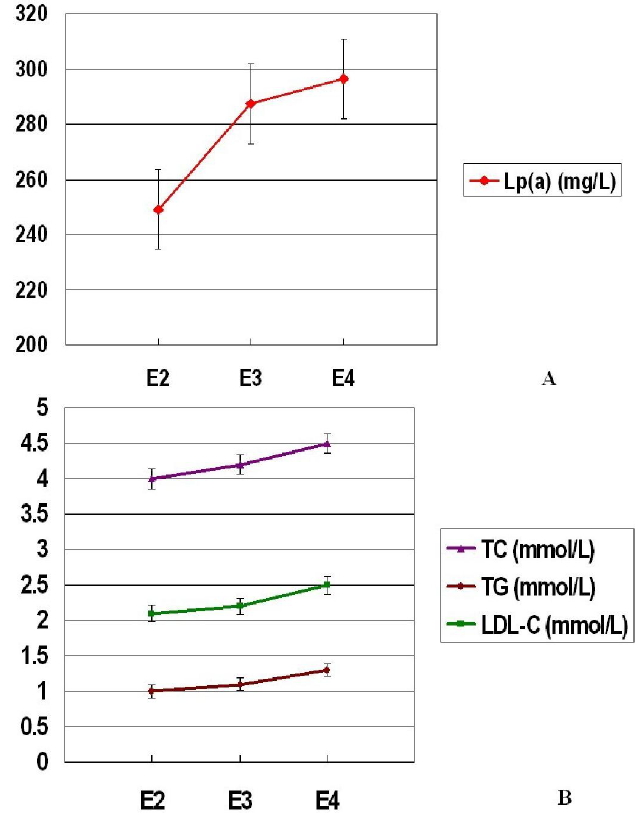
Figure 1. The influence of APOE alleles on serum lipid concentrations in the Guangxi Zhuang children. Though no significant differences in serum lipid concentrations